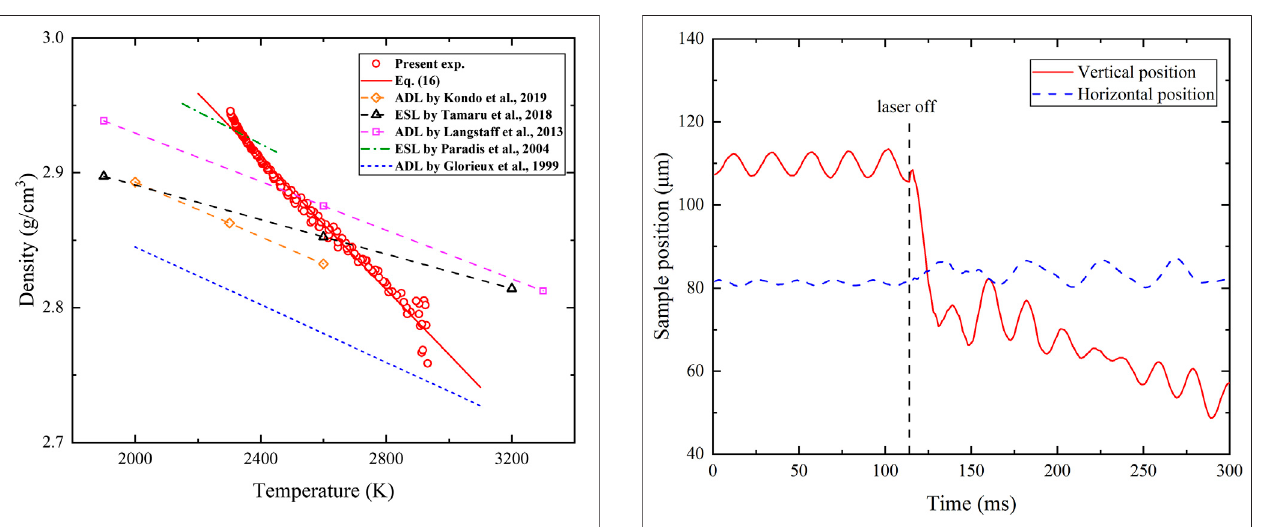
FIGURE7| Positionchangeafterturningtheupperlaseroff(they-axisis offset for zoom-in